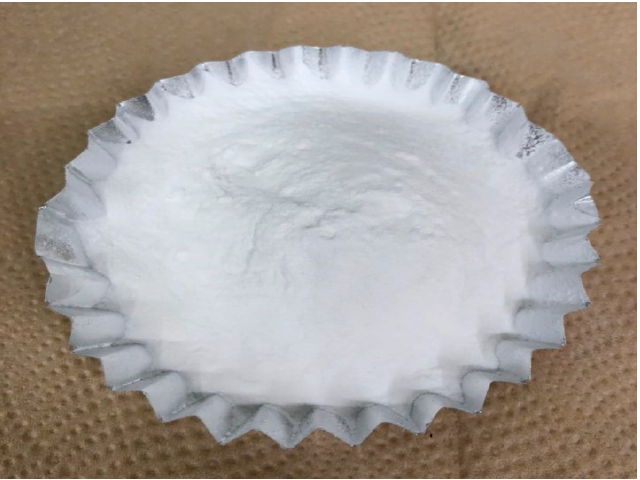
Figure 1. Superabsorbent polymer (SAP). Table 3. Water absorptivity of the SAP.